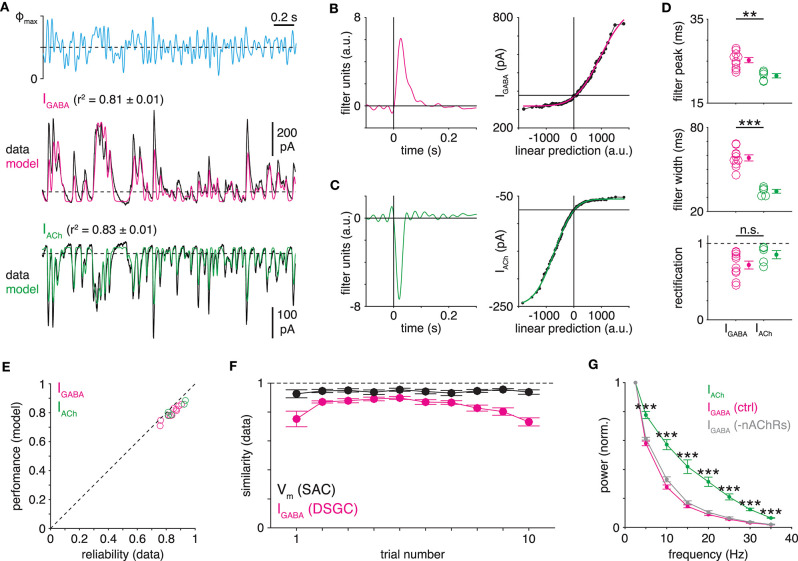
Transmitter-specific kinetics of SAC→DSGC transmission. (A) LN models obtained from IPSCs (IGABA) and EPSCs (IACh) recorded in ON-OFF DSGCs during optogenetic white-noise stimulation of SACs. Black traces indicate averaged response to 10 stimulus repeats (Φmax = 4.8 × 1017 Q cm−2 s−1). Colored traces show LN model output. Dashed horizontal lines indicate the response at a linear prediction of 0 [see (B),(C)]. (B,C) Linear filters (left) and static nonlinearities (right) obtained from IPSCs (B) and EPSCs (C) shown in (A). Horizontal line overlaid on each static nonlinearity indicates the response at a linear prediction of 0; this value is used to calculate rectification (see Materials and Methods). (D) Measurements of LN model components obtained from IPSCs (n = 10 cells) and EPSCs (n = 5 cells) recorded in ON-OFF DSGCs. (E) Relation between LN model performance and data reliability [average similarity; see (F), Materials and Methods] for all PSC recordings. Dashed line indicates unity. (F) Similarity of ChR2-evoked responses to repeated stimuli on a trial-by-trial basis for SAC Vm (n = 9 cells; black) and ON-OFF DSGC IPSC (n = 10 cells; IGABA, magenta). Similarity is the Pearson correlation coefficient between the response during the nth trial and the mean of responses during all other trials. (G) Frequency analysis of IPSCs and EPSCs recorded in ON-OFF DSGCs. IPSCs were recorded in the absence (ctrl, magenta) or presence (gray) of hexamethonium (50 μM), a nicotinic ACh receptor (nAChR) antagonist. Prior to averaging across cells, each power spectrum was normalized to its power at 2.5 Hz. Power spectra are derived from the entire 100-s WN PSC recording. **p < 0.05; ***p < 0.001.